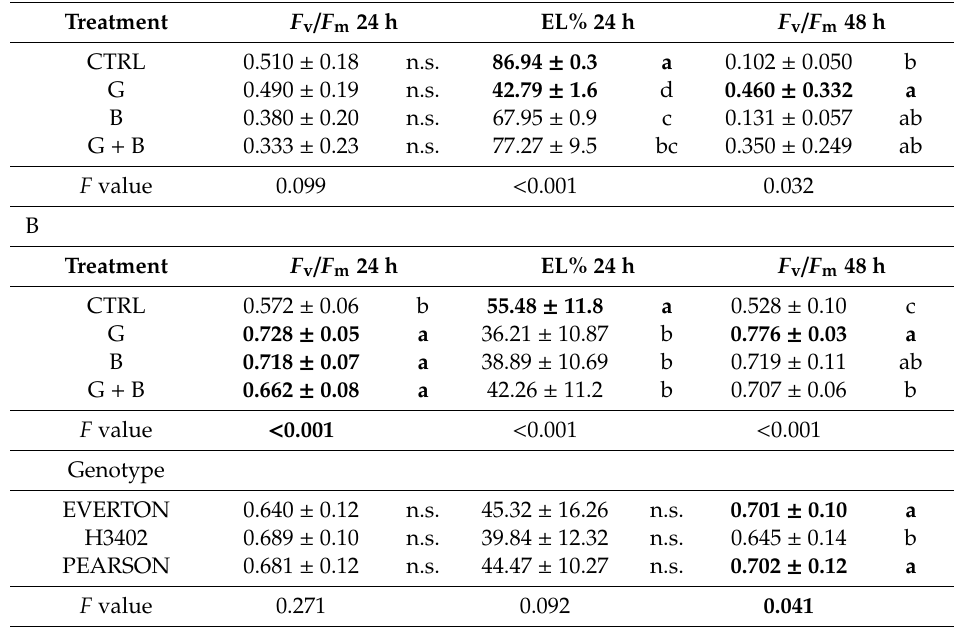
Table 3. Parameters measured at the end of chilling stress and after 24 h in the first and second experiment ( A and B , respectively). F v / F m = photochemical e ffi ciency of photosystem II (PSII), EL = electrolyte leakage, 24 h = measured or recorded immediately after the stress, 48 h = measured or recorded 24 h after the end of the stress, CTRL = seedlings without microorganism treatment, G = seedlings inoculated with Funneliformis mosseae , B = seedlings inoculated with Paraburkholderia graminis , G + B = seedlings inoculated with Funneliformis mosseae + Paraburkholderia graminis , TREAT = treatment, GENO = genotype. Data are presented as mean ± standard deviation (SD) (in the first experiment n = 5; in the second experiments n treatment = 15 and n genotype = 20). Di ff erent letters indicate statistically significant di ff erences among treatments or genotypes by ANOVA followed by Duncan’s test at p < 0.05, n.s. = not significant, ** = p < 0.01, * = p < 0.05. Bold fonts indicate higher